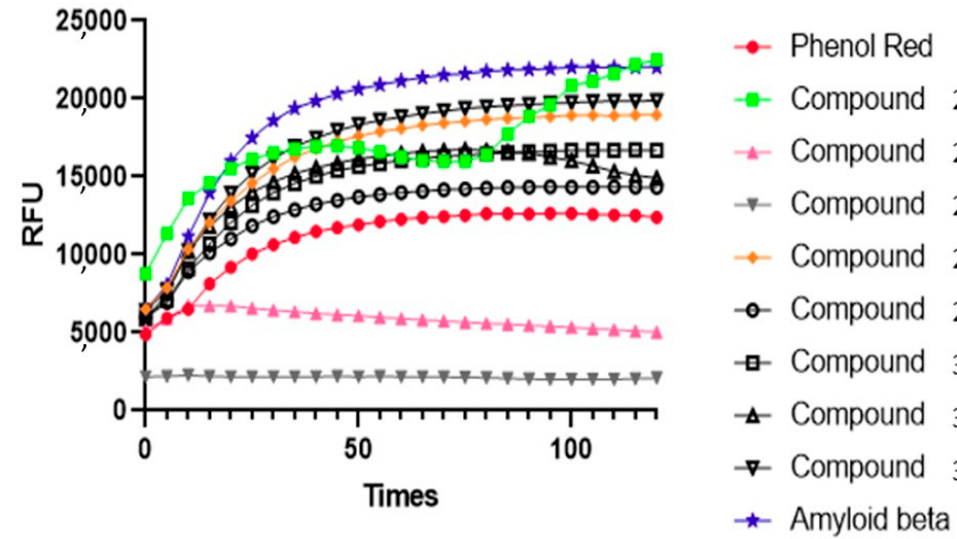
Figure 4. ThT fluorescence assay. Select extended chalcone compounds ( 25–32 ) at 100 µ M with Phenol red (100 µ M) as a positive control. Fluorescence was recorded every 5 min for 120 min.